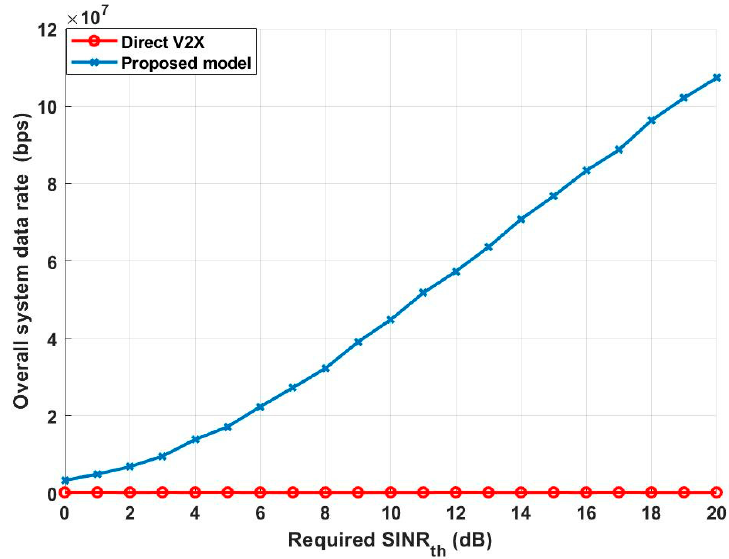
Figure 6. Required SINR thVX vs. overall system data rate (bps).